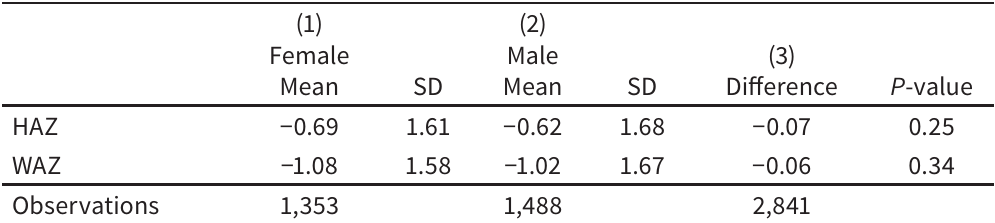
Health of children by sex (year